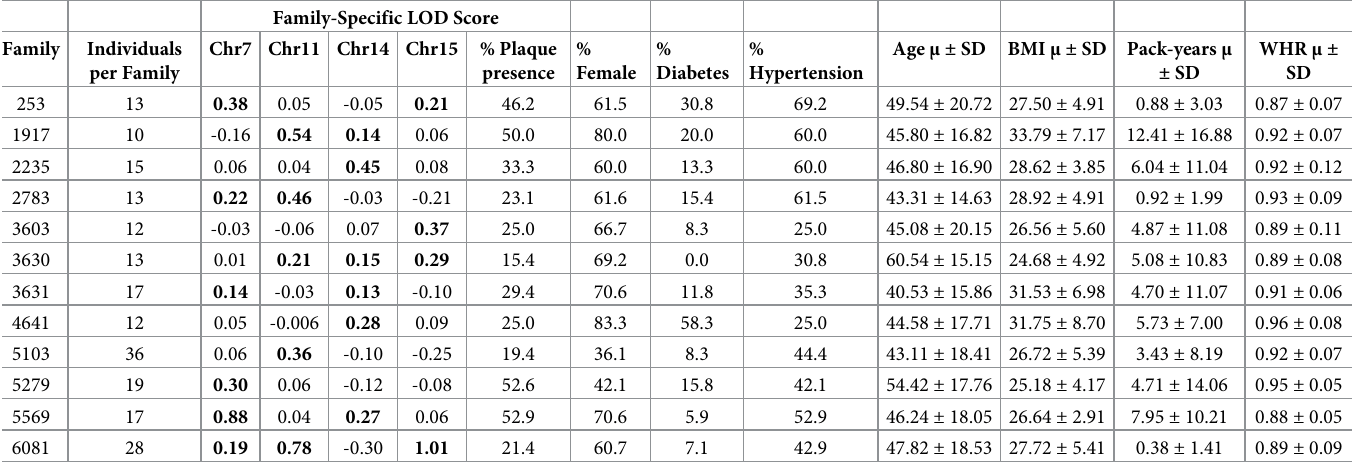
Table 1. Characteristics of the 12 sequenced Dominican families.